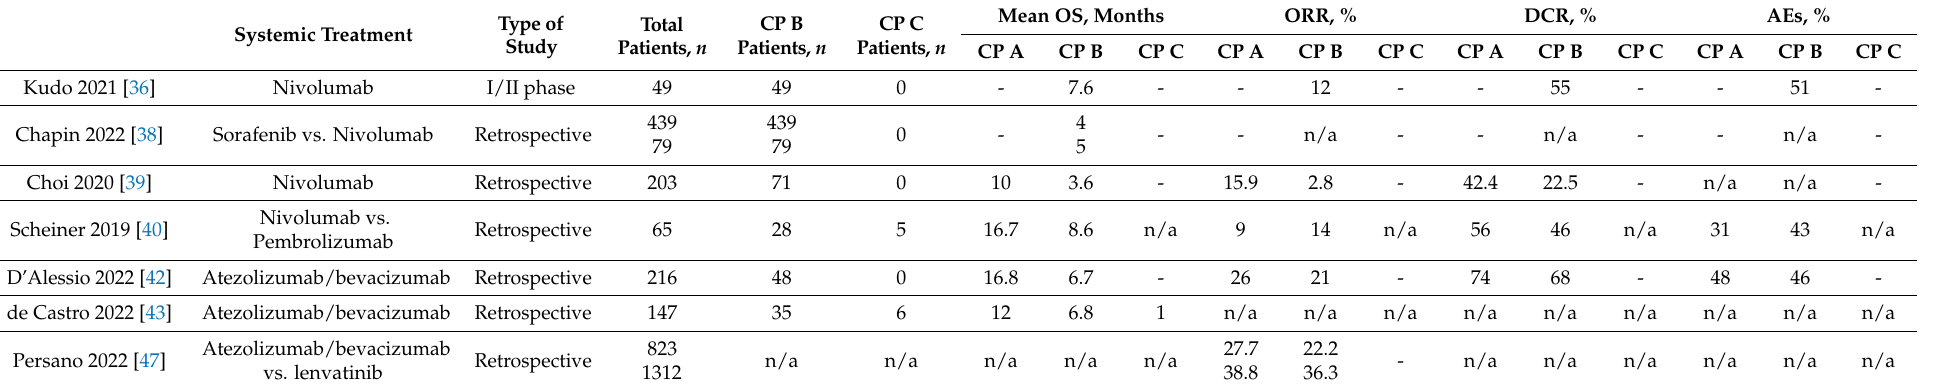
Table 2. Studies examining the efficacy and safety of Immune Checkpoint Inhibitors (ICIs) in patients with decompensated cirrhosis and hepatocellular carcinoma. Systemic